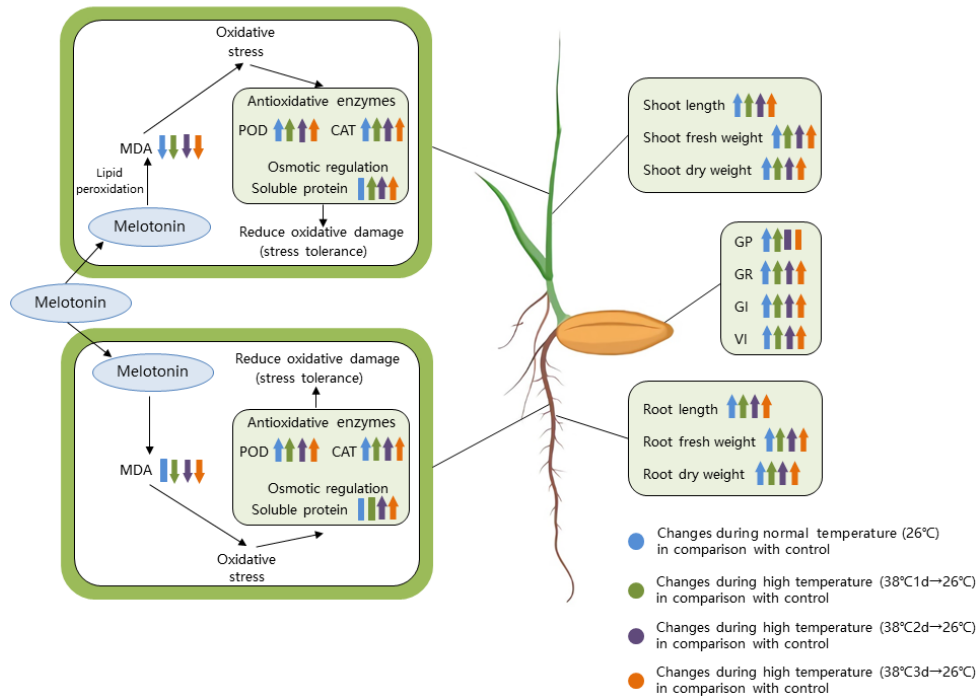
Figure 13. Schematic diagram of the changes in the morphophysiological parameters when 100 μM melatonin alleviates high temperature stress in rice seed germination. ( ↑ ), ( ↓ ), (|) and other symbols represent up-regulation and down-regulation, respectively, and there is no significant change in each parameter.